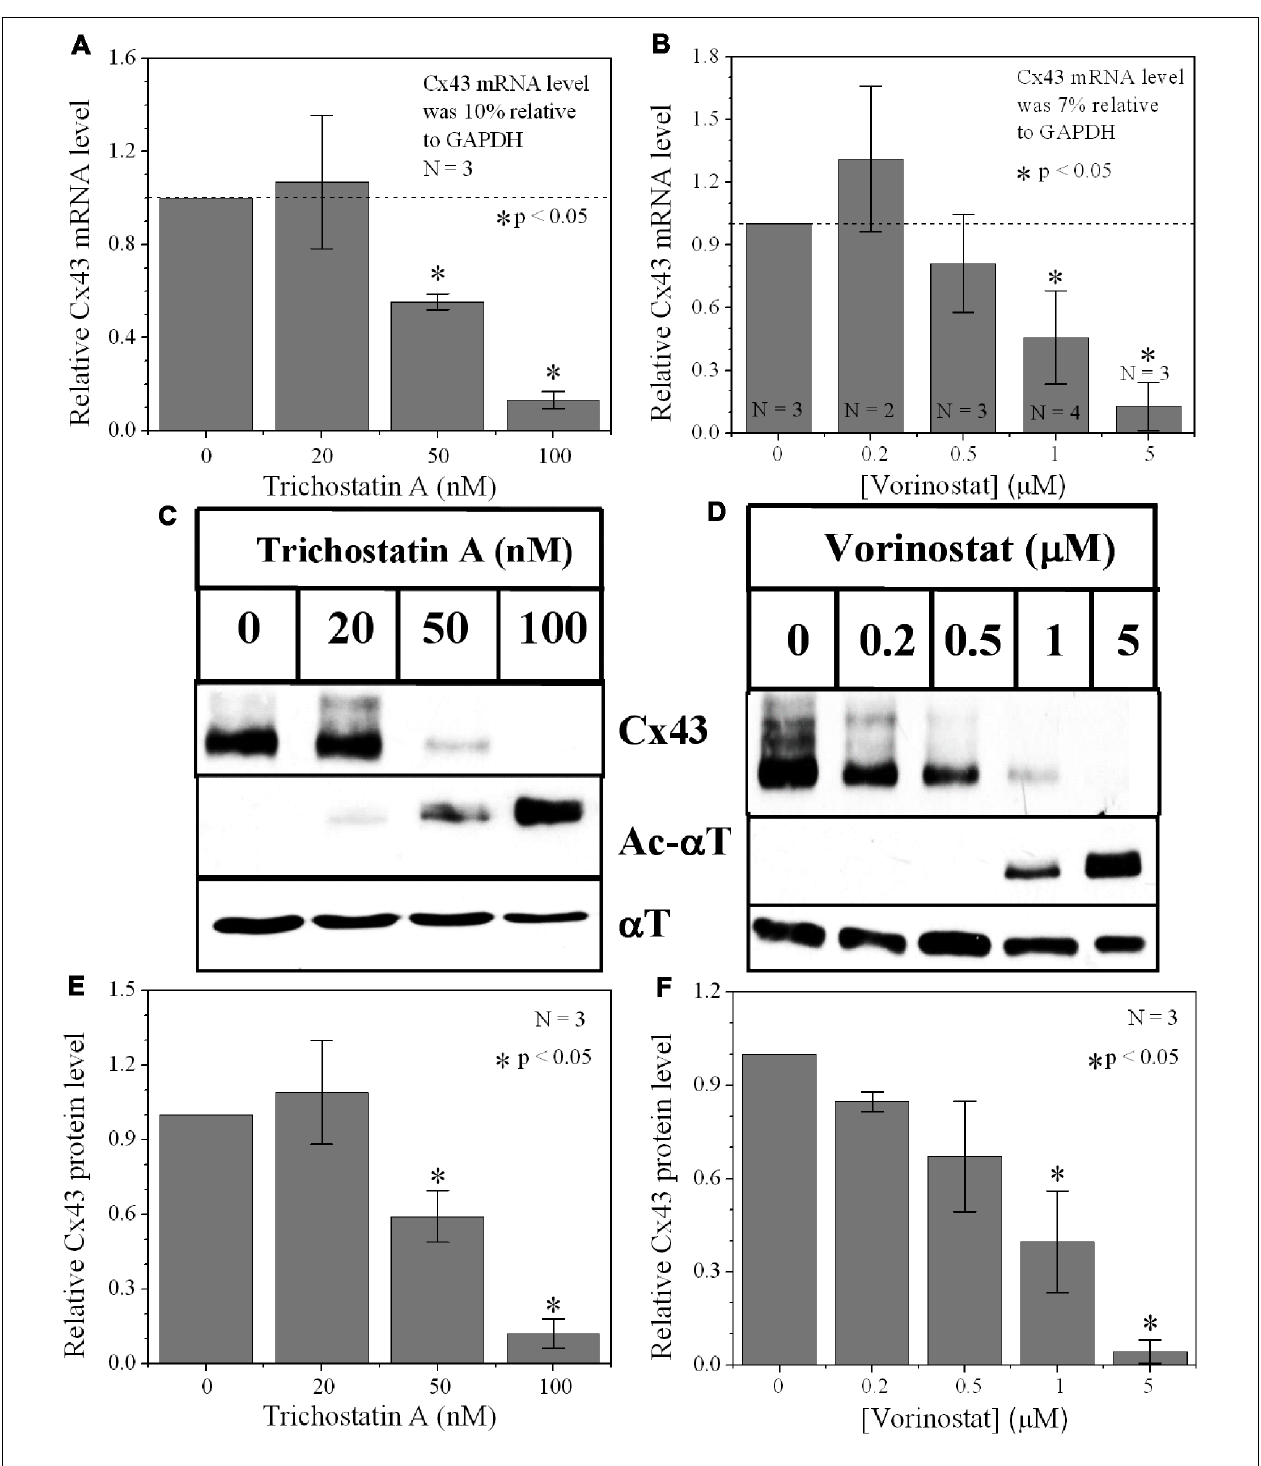
ventricular cell lysates fromTSA (C) orVOR (D) treated cultures. (E,F) Statistical analysis of the protein densitometry scans from three experiments reveal significant dose-dependent reductions in Cx43 protein content. Cx43 protein levels were normalized to a control sample from each experiment with α -tubulin ( α T) expression used as an internal control and acetylated α -tubulin (Ac- α T) as a positive indicator for HDAC